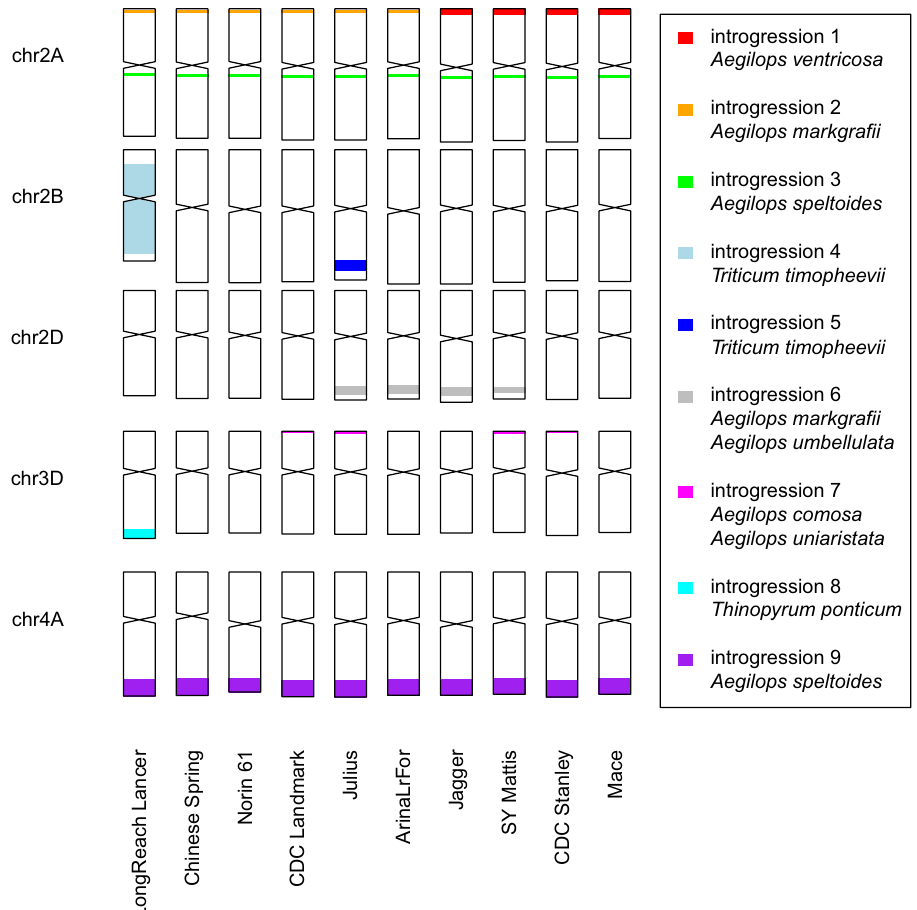
Figure 1. Overview of detected introgressions and putative donor species in the 10 wheat reference quality assemblies